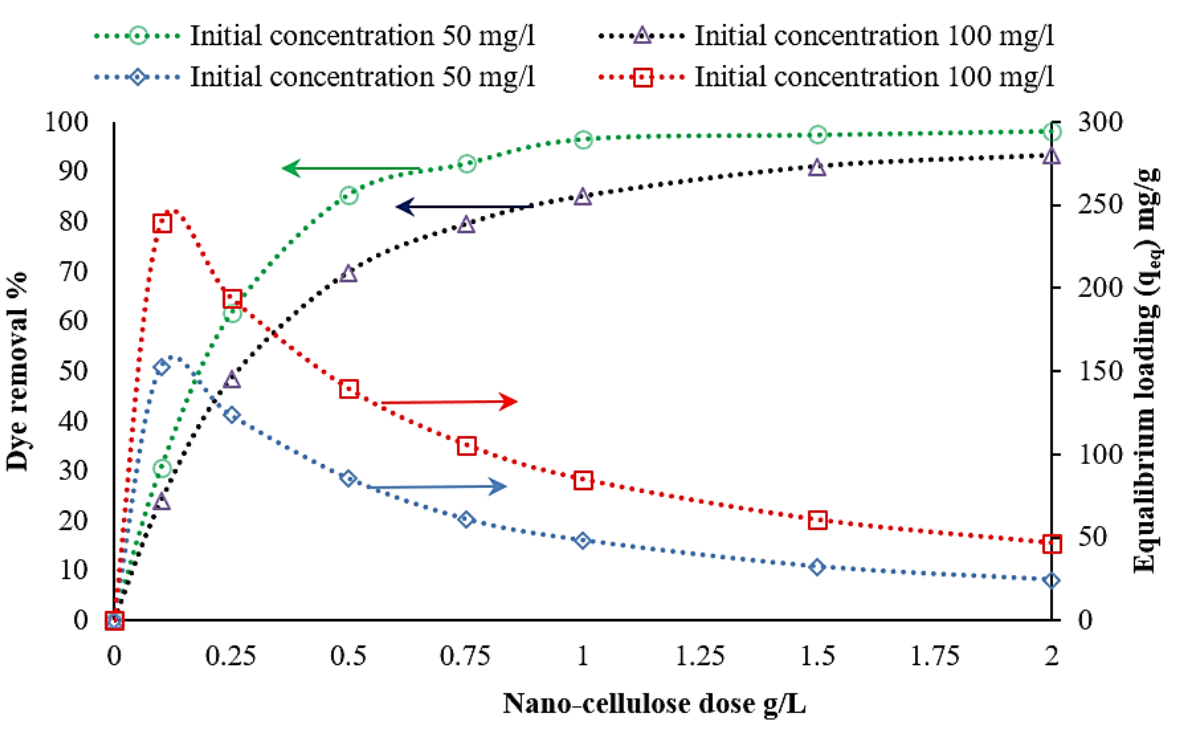
Figure 11. Effect of nanocellulose concentration on DB78 dye removal efficiency (temperature of 22 °C, pH of 2, mixing speed of 150 r.p.m., and contact time of 30 min).